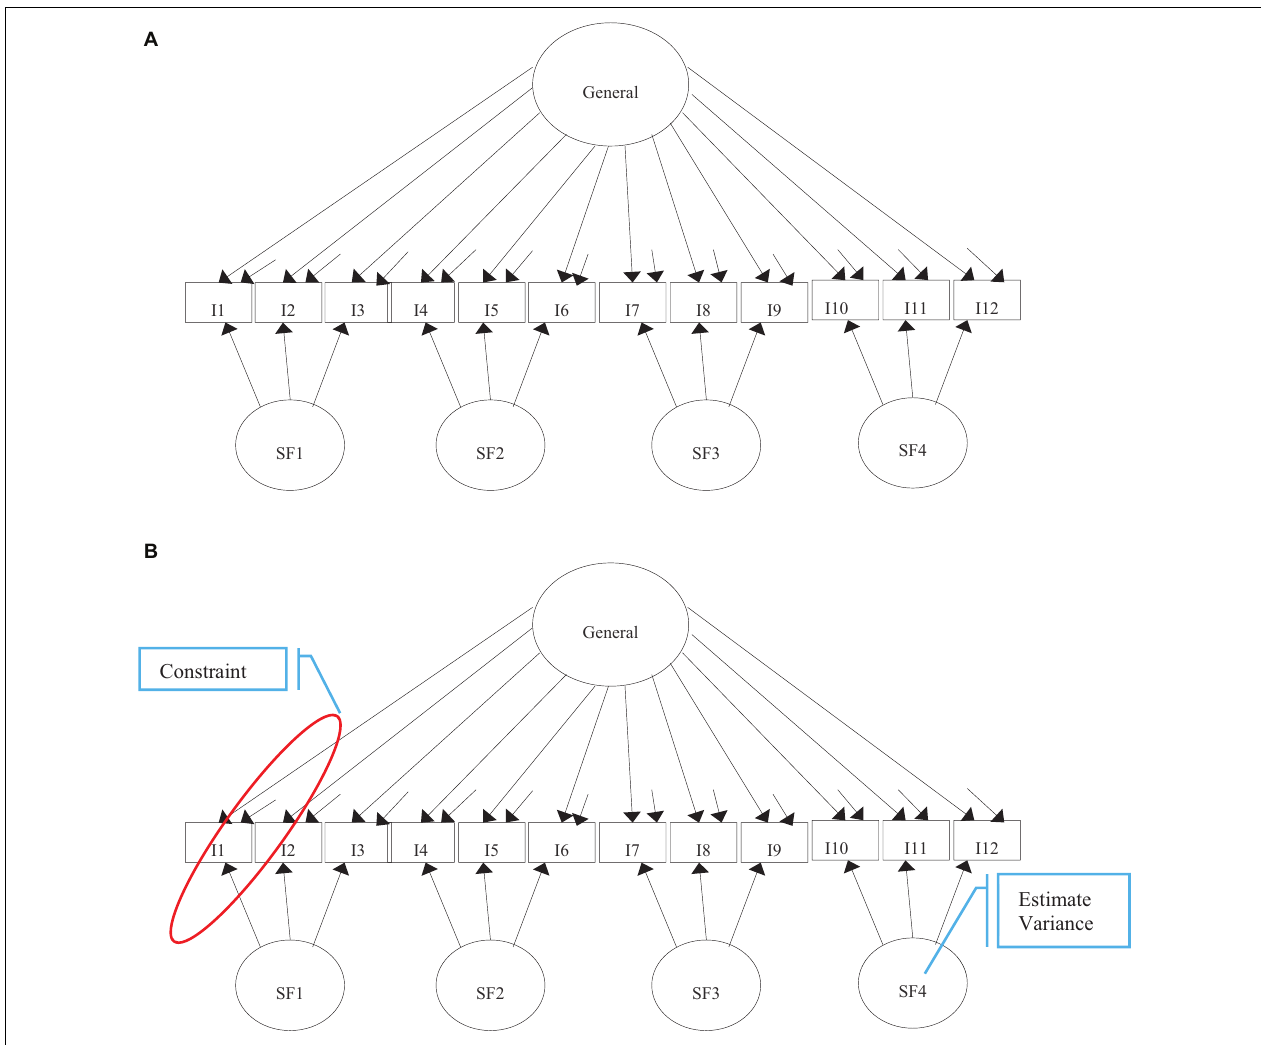
FIGURE 1 | Path diagrams of the tested models. (A) Conventional bifactor. (B) Restricted bifactor. SF, Specific